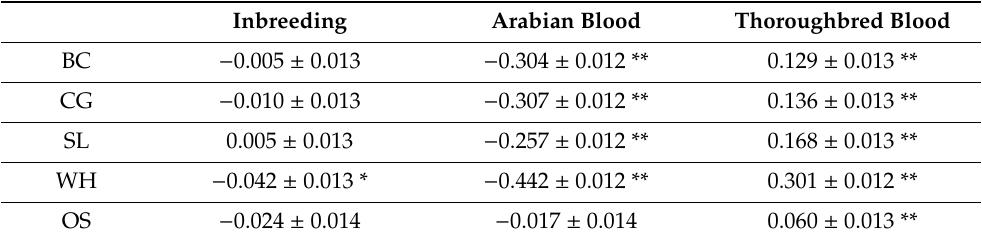
Table 3. Linear correlation coefficient ± s.d. of body traits with inbreeding coefficient, Arabian blood percentage and Thoroughbred blood percentage.